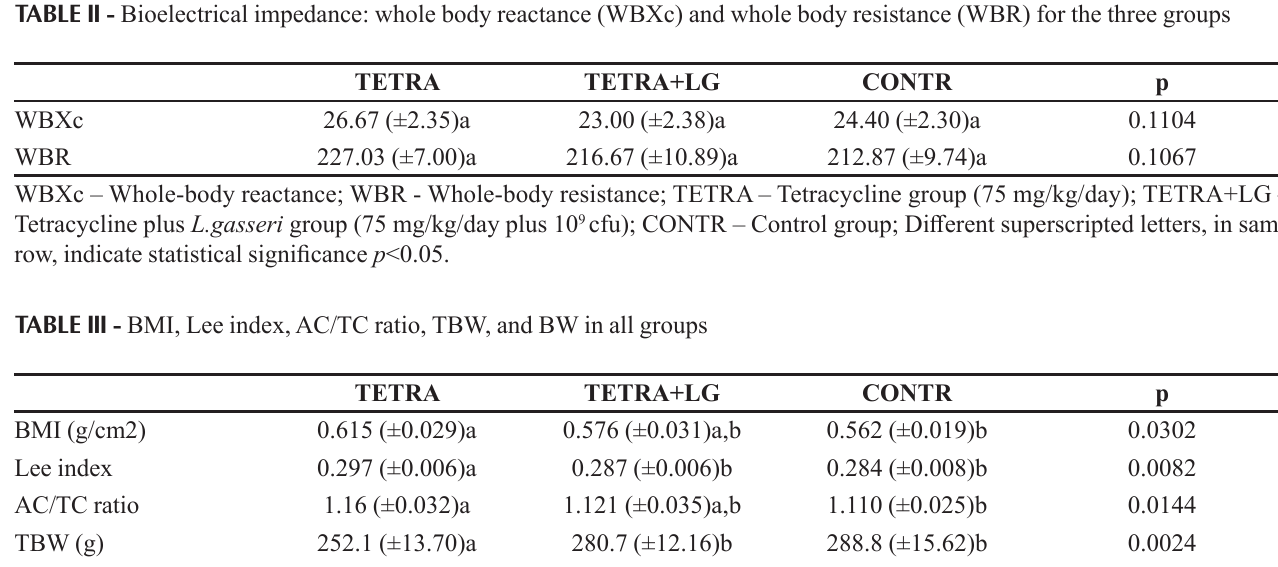
TABLE II - Bioelectrical impedance: whole body reactance (WBXc) and whole body resistance (WBR) for the three groups